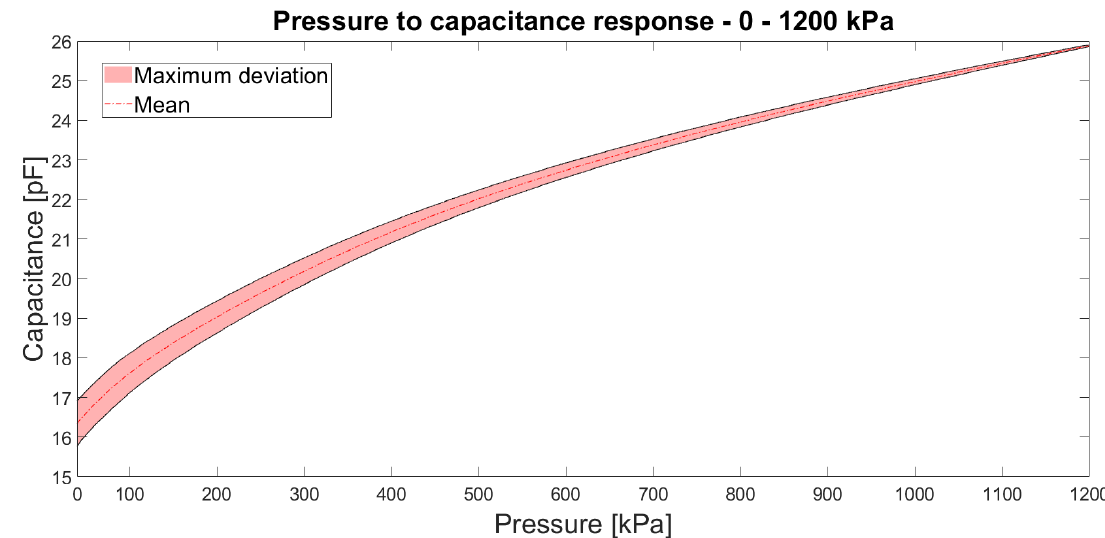
Figure 6. Capacitance-to-force curve of the sensor in the range from 0 to 1200 kPa. The red dashed line shows the mean capacitance value over pressure. The light-red area shows the maximum deviation of capacitance over the pressure